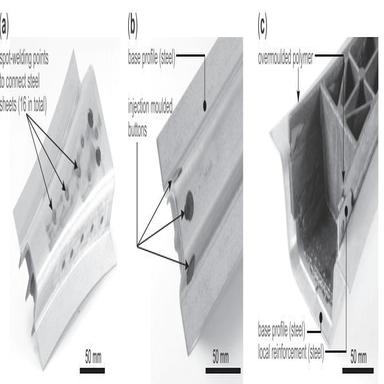
Joint types applied in A-frame samples: (a) spot welding points for steel-steel connections, (b) polymer buttons injected through holes in the steel profile, and (c) overmoulding of steel edges with polymer. Furthermore, there are adhesion joints between the composite layer and steel over their entire connecting surface (c.f. between components i/ii and iii).